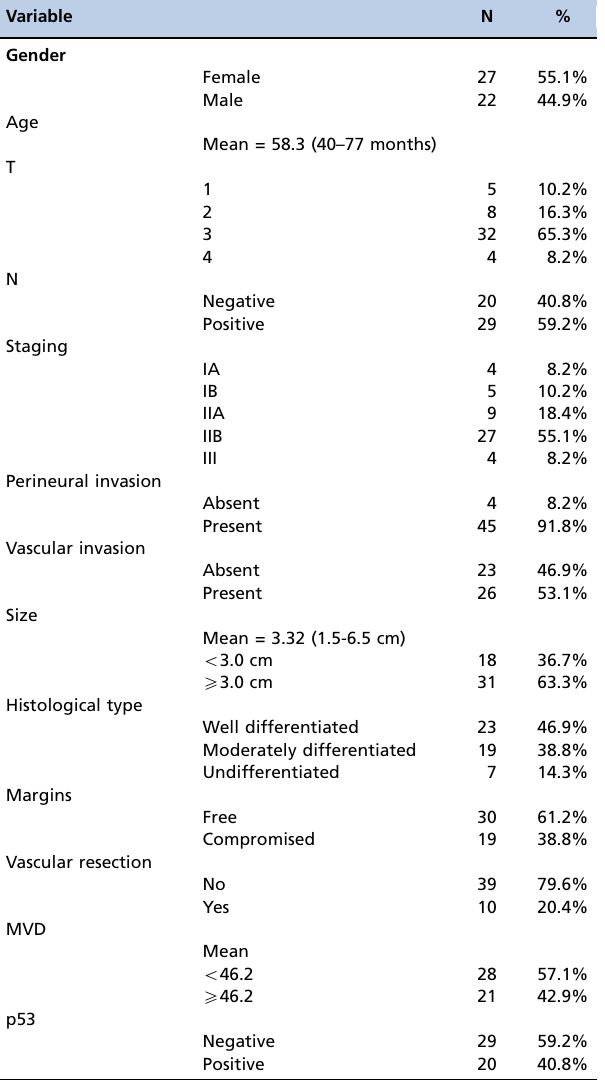
Table 1 - Demographic and clinicopathologic